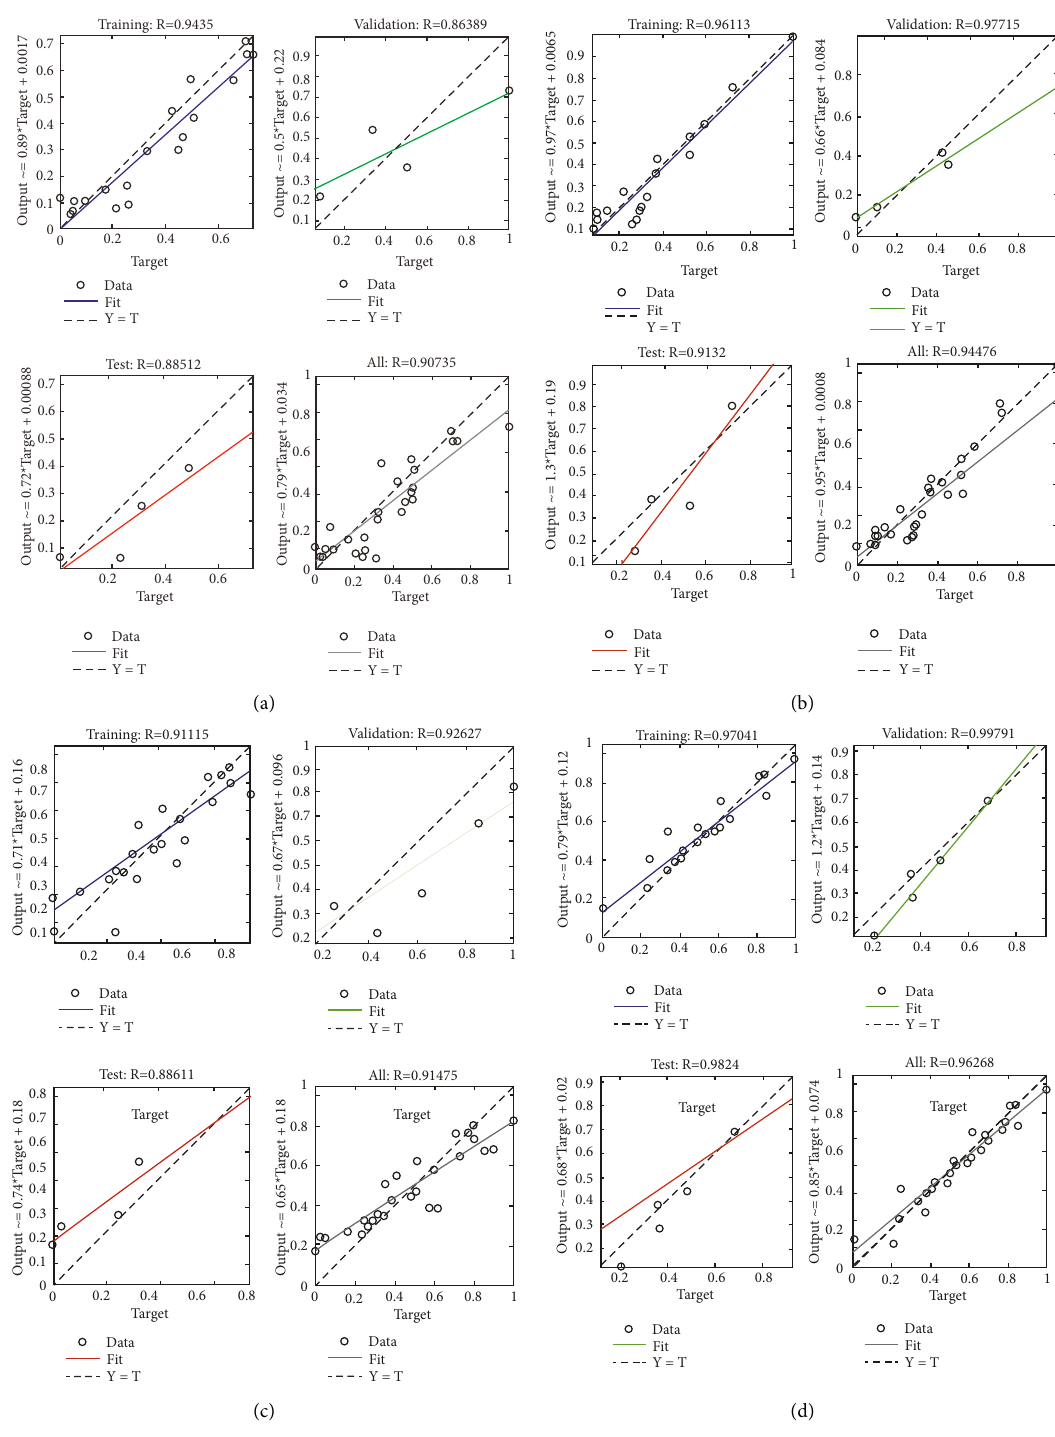
Figure 2: Schematic diagram of network regression analysis of various water quality